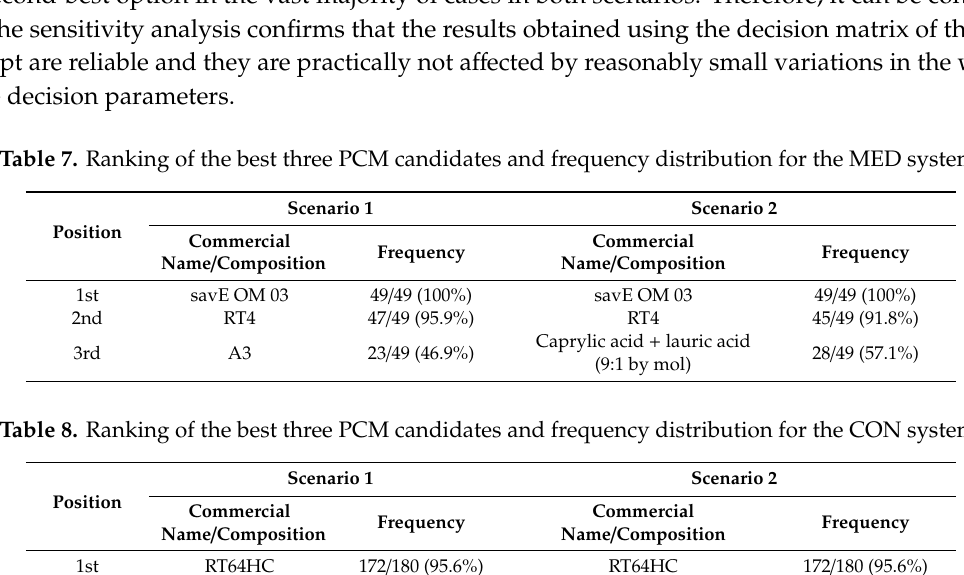
Table 8. Ranking of the best three PCM candidates and frequency distribution for the CON system.